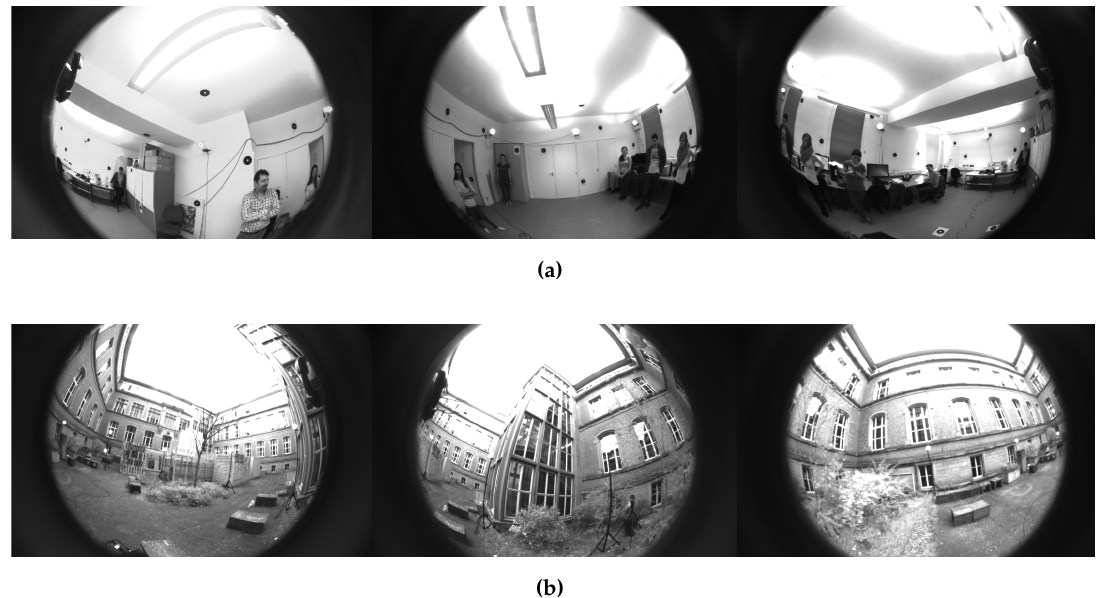
Figure 3. Set of three fisheye images acquired ( a ) indoors and ( b )